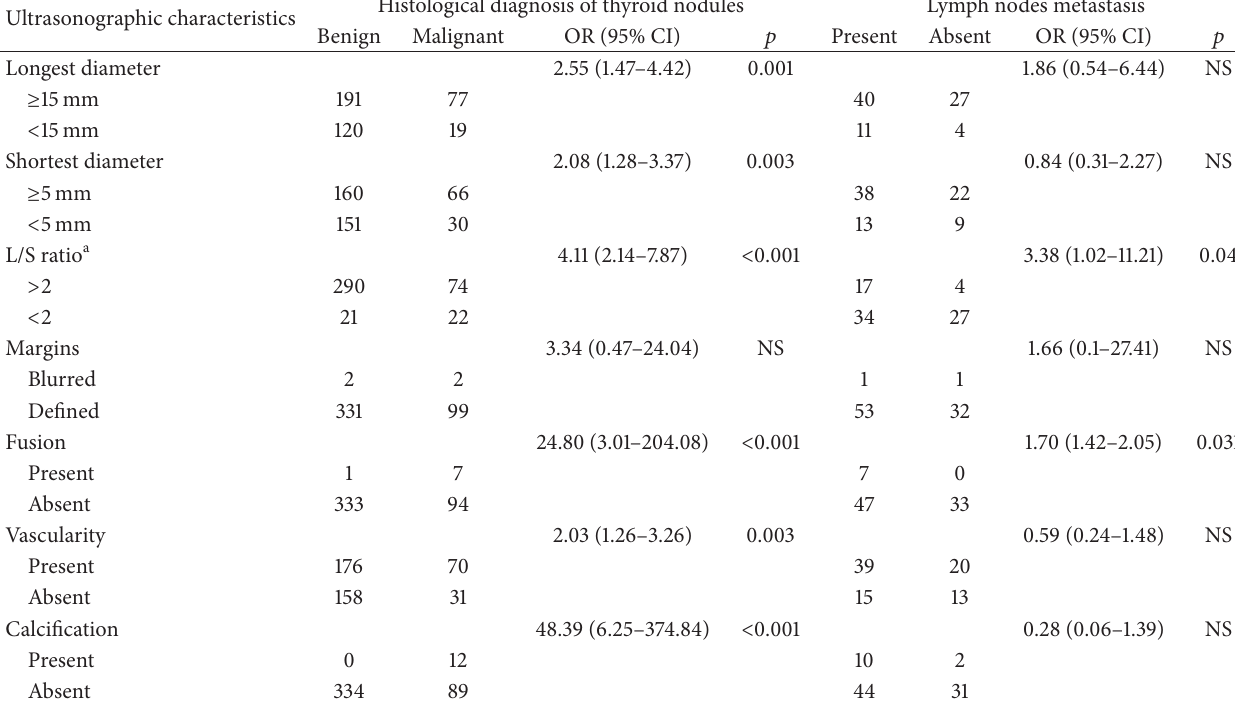
Table 6: Ultrasonographic characteristics of cervical lymph nodes and histological